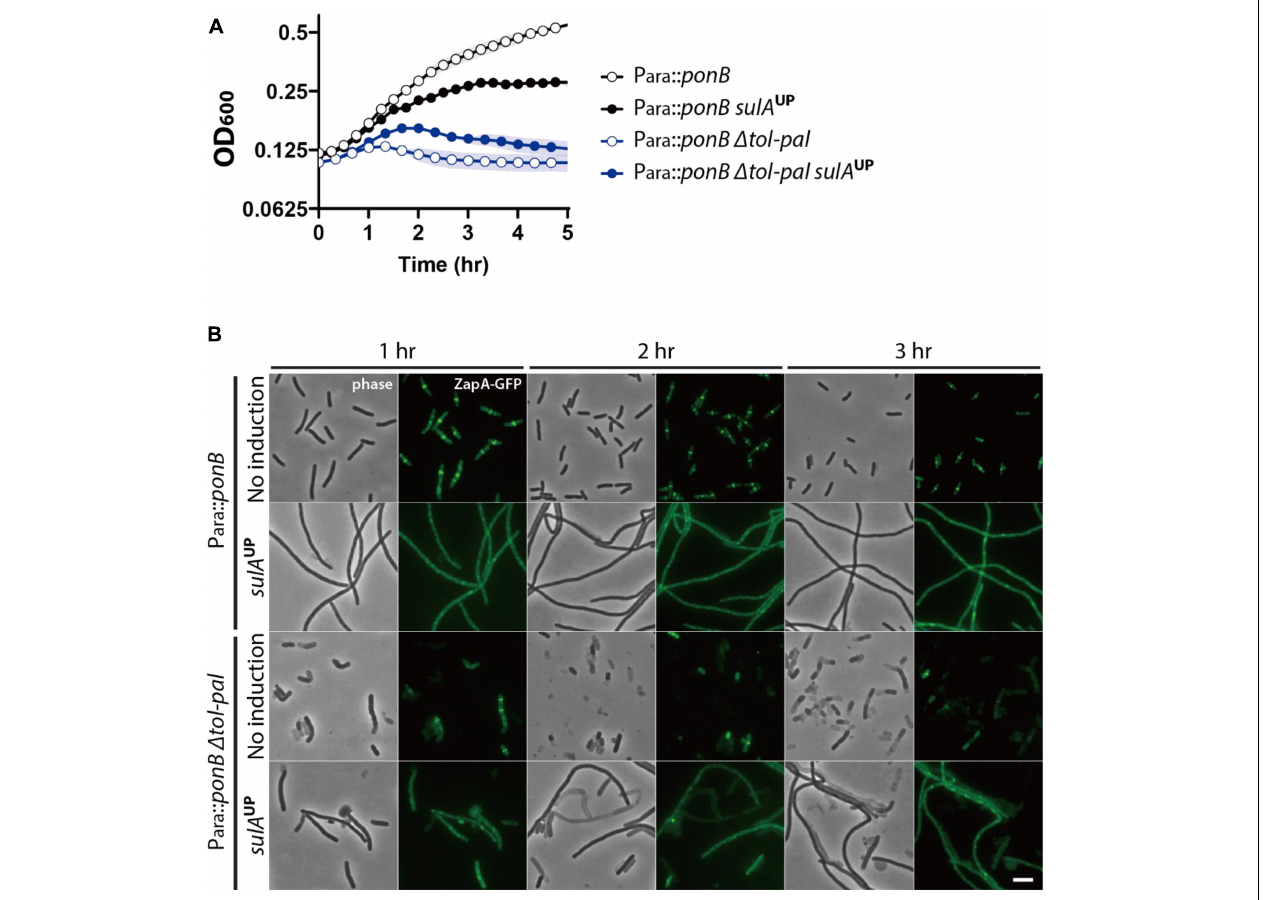
FIGURE 5 | Lysis induced by ponB depletion in the tol-pal mutant is only partially suppressed by division inhibition. (A) SP199 (P ara : ponB , zapA-gfp ) and SP200 (P ara : ponB , (cid:49) tol-pal , zapA-gfp ) strains harboring pSP6 (P tac : sulA ) were grown overnight in LB supplemented with 0.2% arabinose and 5 µ g/ml tetracycline at 37 ◦ C. The overnight cultures were washed, diluted in LB supplemented with 5 µ g/ml tetracycline but lacking arabinose to an OD 600 of 0.02, and grown for 2 h to an OD 600 between 0.2 and 0.3 at 37 ◦ C to deplete ponB expression. Then, the cultures were washed in no salt LB, and diluted to an OD600 of 0.1 in no salt LB lacking or supplemented with 1 mM IPTG for induction of sulA expression. The optical density of the cultures was measured in the same way as in Figure 1 except that the culture plate was incubated at 37 ◦ C in the plate reader. (B) The same cultures in no salt LB lacking or supplemented with 1 mM IPTG were grown in test tubes at 37 ◦ C for visualization of the lysis phenotype of each strain. The cells in the cultures were imaged using phase contrast and GFP optics at 1–3 h after dilution in no salt LB to monitor lysis and divisome assembly. The scale bar represents 5 µ